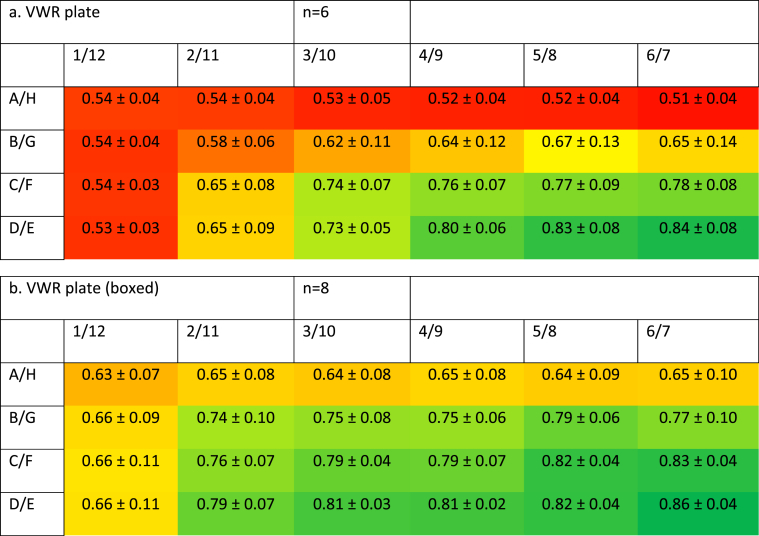
Profile of metabolic activity of cells grown in VWR plates. SW480 cells were grown for 72 h before being subjected to an MTS proliferation assay. Data show absorbance (490 nm) increase and standard deviation of sample data following a 2-h incubation in the presence of MTS reagent (calculated using Microsoft Excel) and represent n = 6.2a: incubated alone. 2b: incubated with packaging.